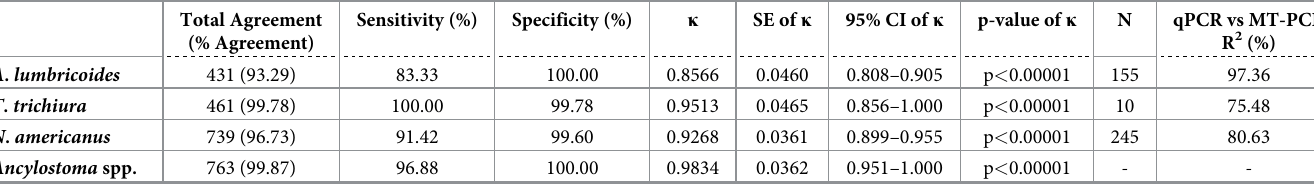
Table 2. Interrater reliability as defined by kappa agreement values (Cohen’s kappa, κ ) including standard error of κ , 95% confidence interval (CI) of κ and signifi- cance of κ ; and coefficient of determination (R 2 ) for qPCR vs MT-PCR to determine closeness of data to fitted linear regression line. Standard errors (SE) range from 0.0361 to 0.0465 with a 95% confidence interval ranging from 0.808 to 1.00 among all tests. All p-values for κ are < 0.00001 assuming interrater reliability measure- ments to be significant. R 2 values are given in percentages of the total number of samples validated for each STH species (N). Only samples deemed infection positive by both methods were included in this analysis (1 Ascaris lumbricoides and 3 Necator americanus outliers were removed (highlighted in Fig 2)). All Ancylostoma ceylanicum positive infections represented co-infections with Necator americanus and were subsequently discarded from this analysis.